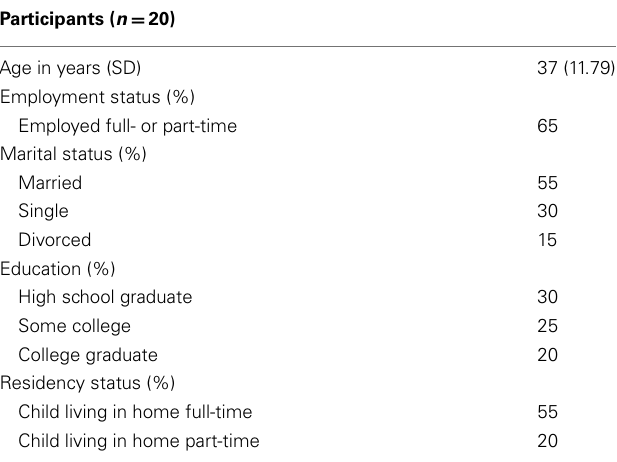
Table 1 | Participant characteristics .